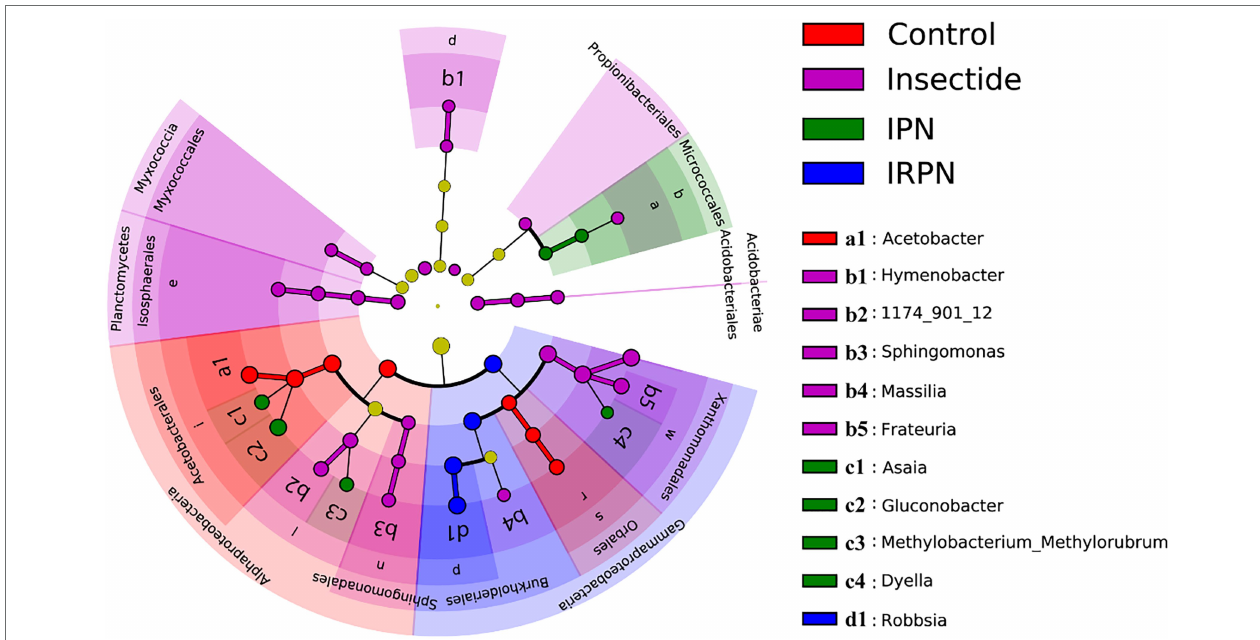
FIGURE 6 | Least discriminant analysis (LDA) effect size taxonomic cladogram for comparing samples collected from the Chinese bayberry trees grown in different planting environments. The discriminant taxon nodes are coloured, and branches are shaded according to the highest ranked group for that taxon. If the taxa were not significantly different between sample groups, the corresponding node is coloured yellow. Select highly abundant taxa are denoted with